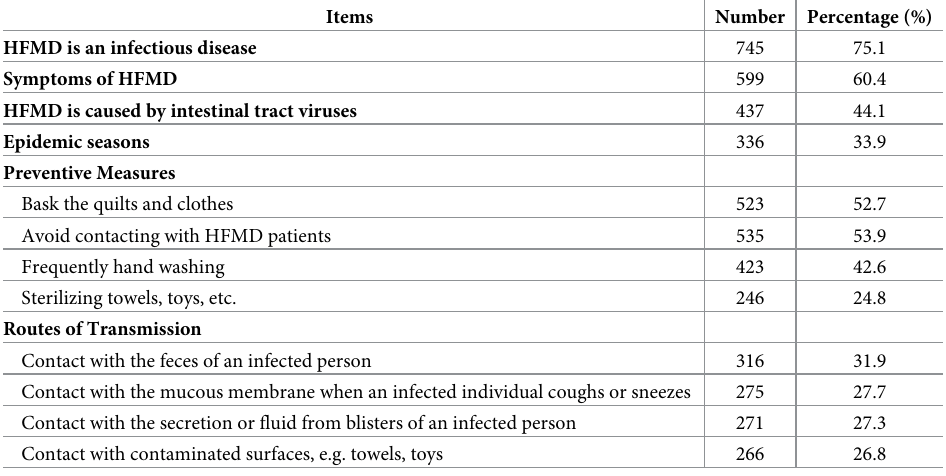
Table 2. Knowledge of HFMD among parents (n = 992) of children < 5 years old in Chongqing, China. Items Number Percentage (%) HFMD is an infectious disease Symptoms of HFMD HFMD is caused by intestinal tract viruses